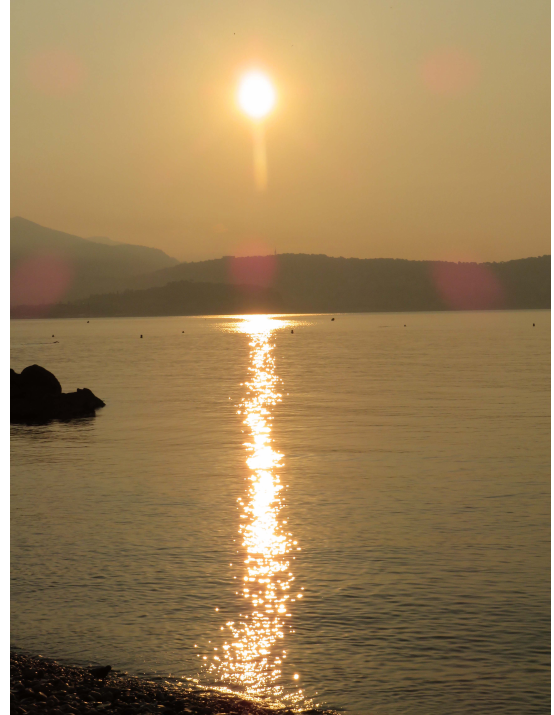
FIG. 3: Sunrise on the Mediterranean in Nice